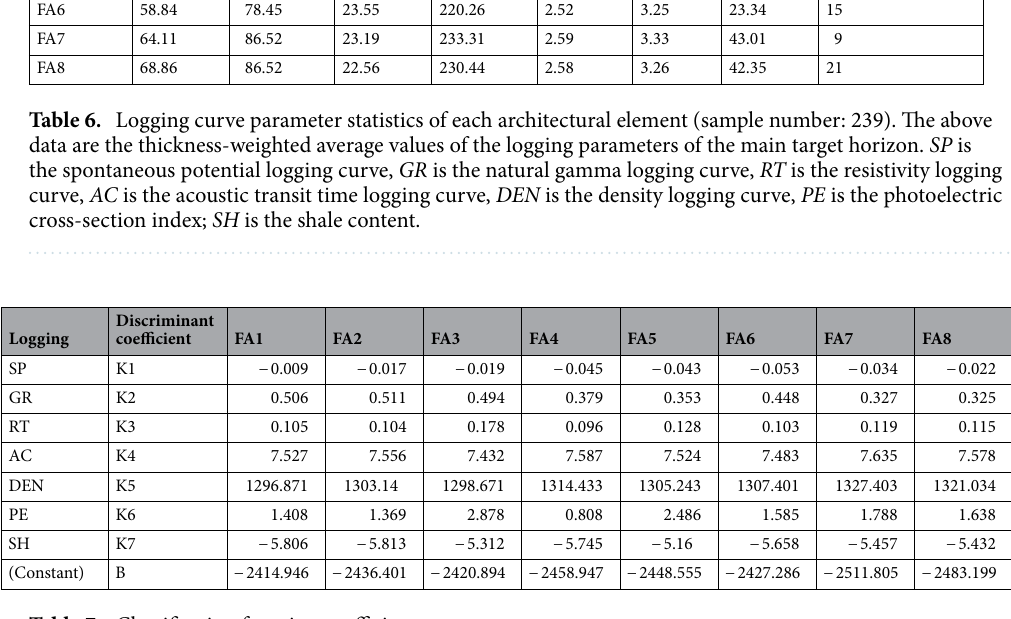
Table 7. Classification function